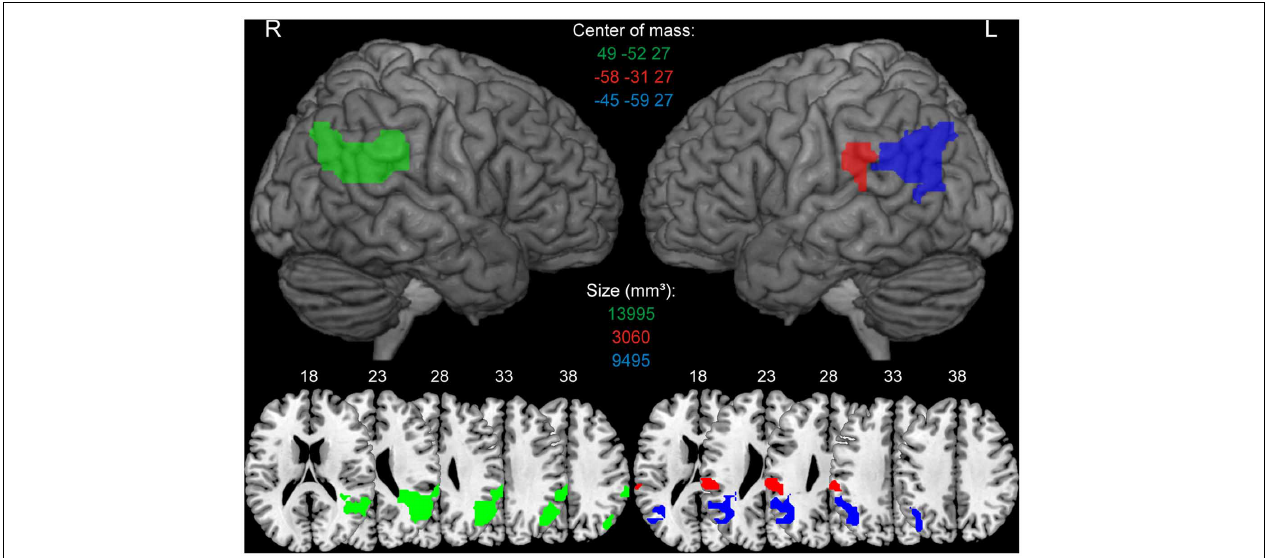
FIGURE 2 | Regions of interests (ROIs) derived from Huberle and Karnath (2012). ROIs were identified as those voxels that showed significantly higher BOLD signals for 20%-scrambled objects (intact global perception) compared to 80%-scrambled objects (disturbed global perception) based on a voxel-level threshold of p < 0 . 001 (uncorr.). The